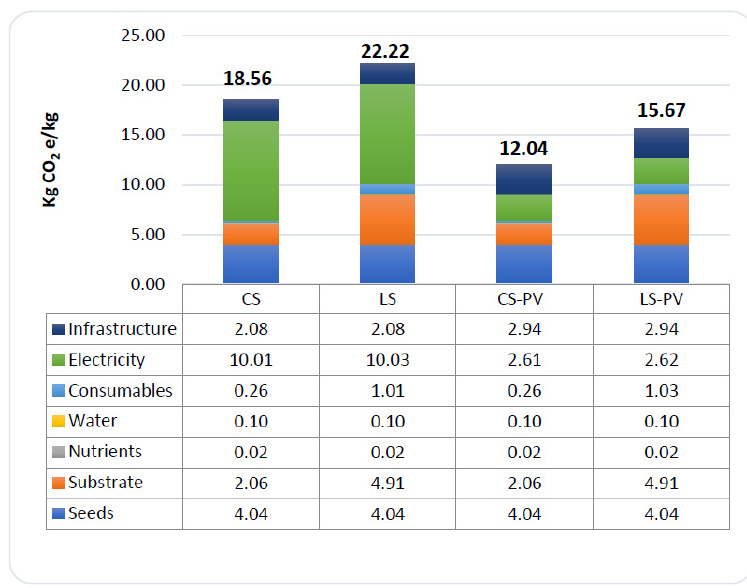
Figure 3. Photovoltaic system (PV) variation of the GWP results of for the building-integrated IVF technology for Circular Supply (CS) and Linear Supply (LS); add the inclusion of PV to infrastructure and PV replacing 70% electricity. Presented are results for global warming potential in carbon emissions (CO 2 e) per kg of fresh weight broccoli microgreens for material inputs.